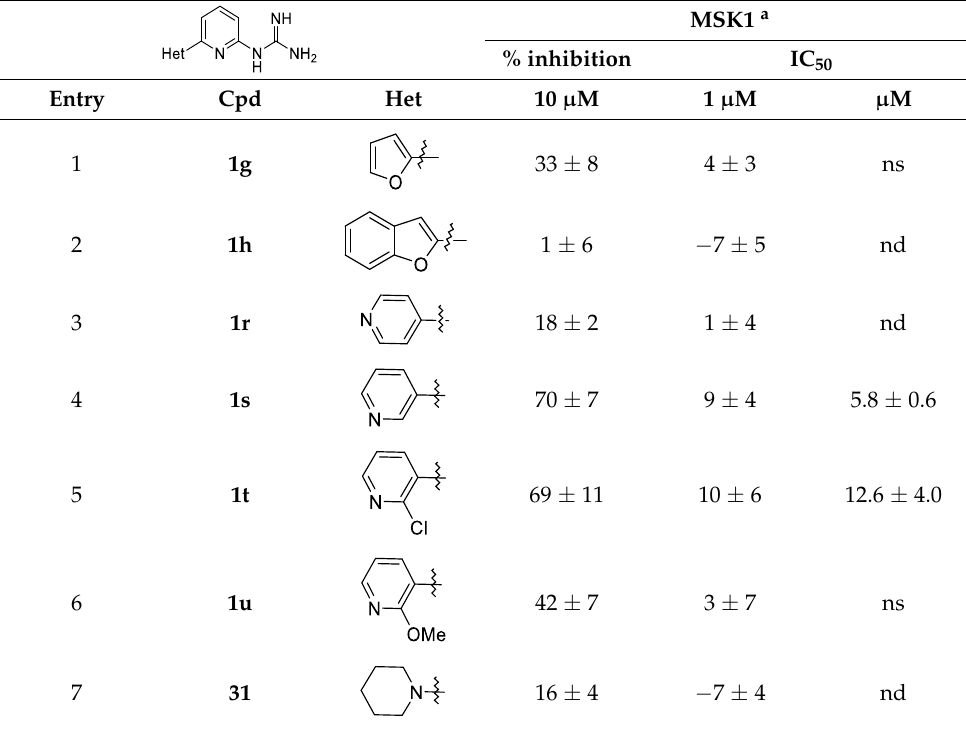
Table 3. Replacement of the phenyl group by heterocycles.